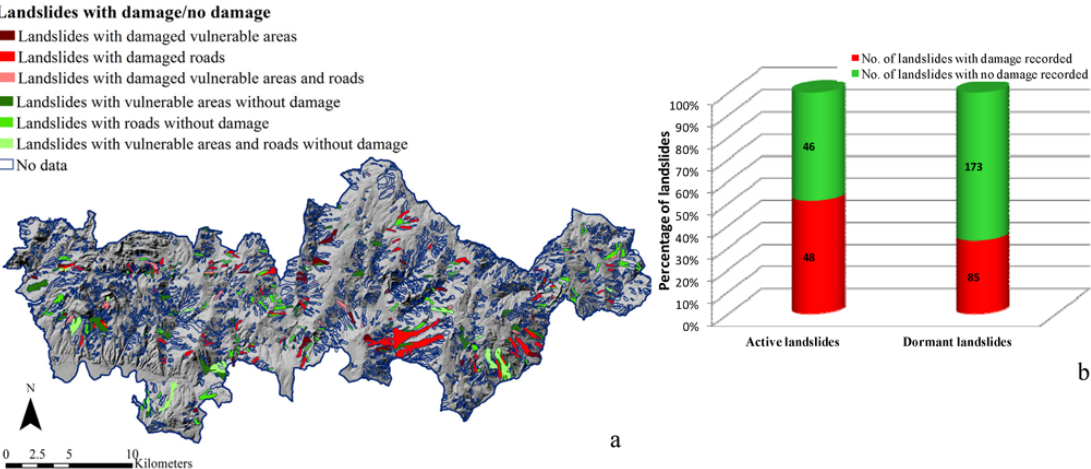
Fig. 19. (a) Map of landslides with or without recorded damage to vulnerable areas and/or roads; (b) comparison among the state of activity of landslides derived from the inventory map and the results of damage surveys.